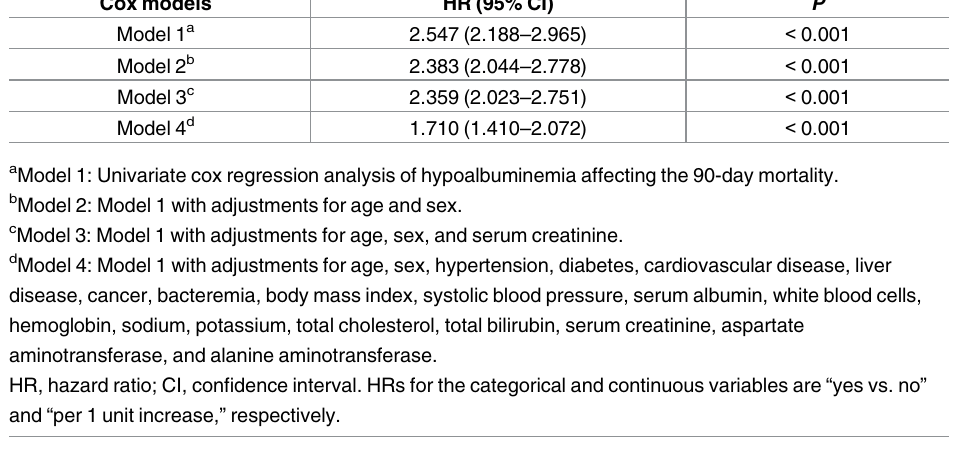
Table 3. Cox regression analysis of the possible predictors of 90-day mortality. Cox models